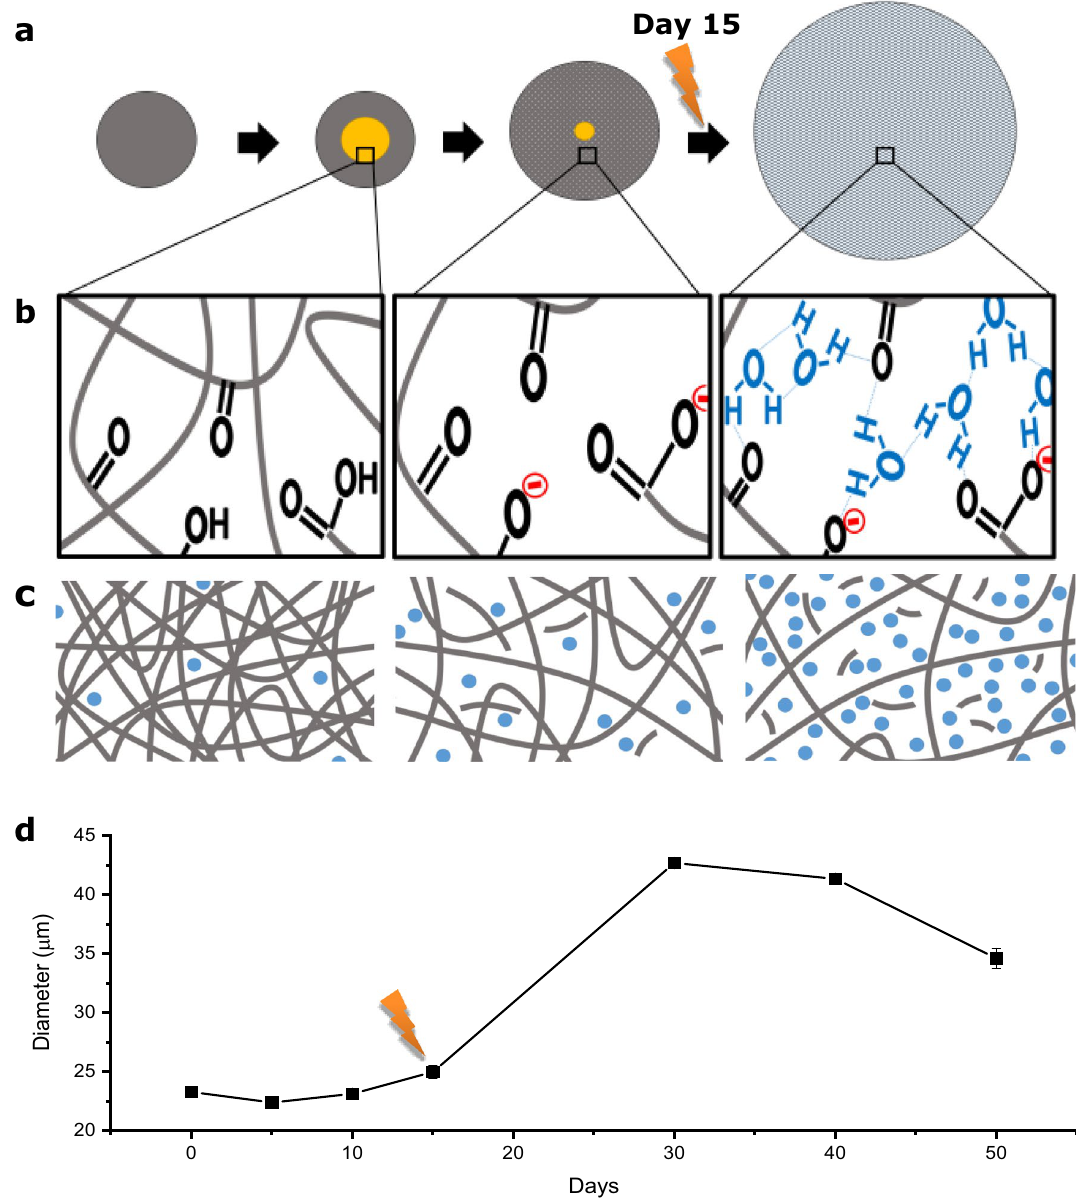
Figure 8. Interplay of expansive intermolecular forces. ( a ) Schematic of microparticle swelling over time. Grey circles represent microparticles. Yellow circles represent the development of an acidic core region and the lightning bolt signifying point of substantial swelling. ( b ) Insets represent the hydrolysis, degradation, hydration shell and swelling that occurs over time in terms of active chemistry. ( c ) The corresponding general view of water ingress over time, subsequent hydrolysis of polymer, and ultimate expansion of relaxed, ionized polymer chains (grey lines represent PLGA polymer chains and blue dots represent water molecules). ( d ) Swelling profile timeline as it correlates with the schematic (taken from 23 µm population